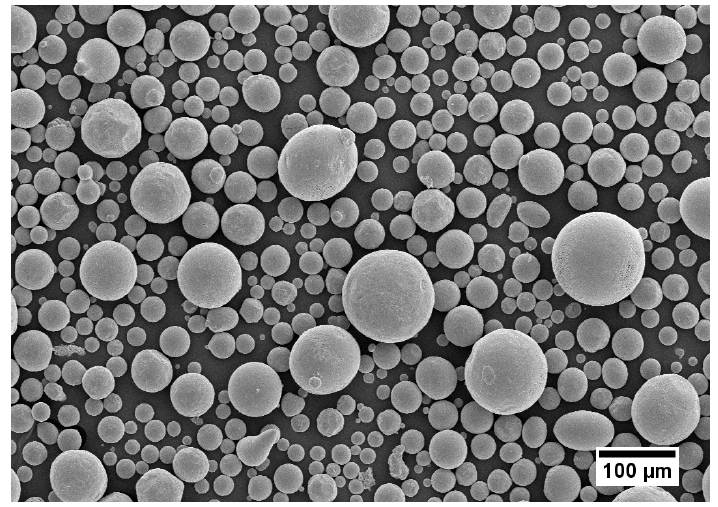
Figure 2. SEM micrograph of SAC305 lead-free solder powder, which was used as feed material for turbo air classification experiments.